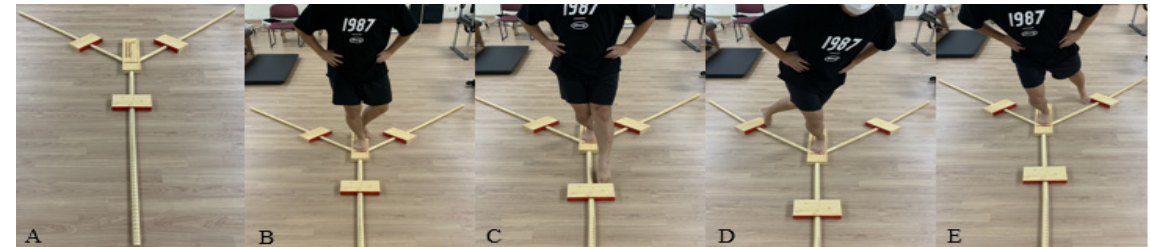
Figure 3. Y-balance test. ( A ) Y-balance test equipment; ( B ) starting posture; ( C ) anterior; ( D ) posteromedial; ( E ) posterolateral.